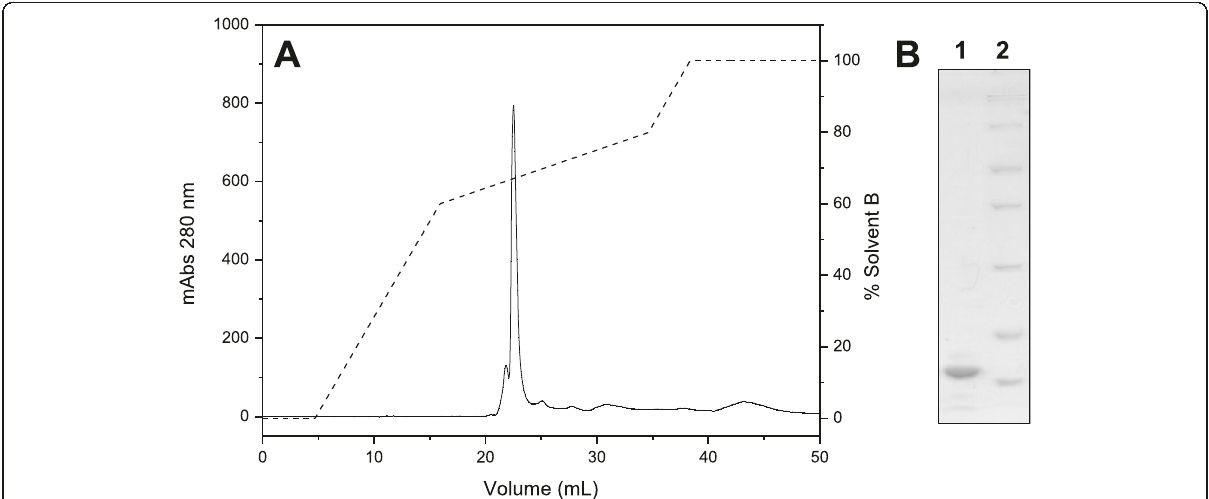
Fig. 4 a Chromatographic profile of fraction 6 on a C18 reverse phase column. Elution was performed using a RP-HPLC system at a flow rate of 0.5 mL/minute using a segmented concentration gradient of 0-60 % solvent B in three column volumes, 60-80 % in five column volumes and